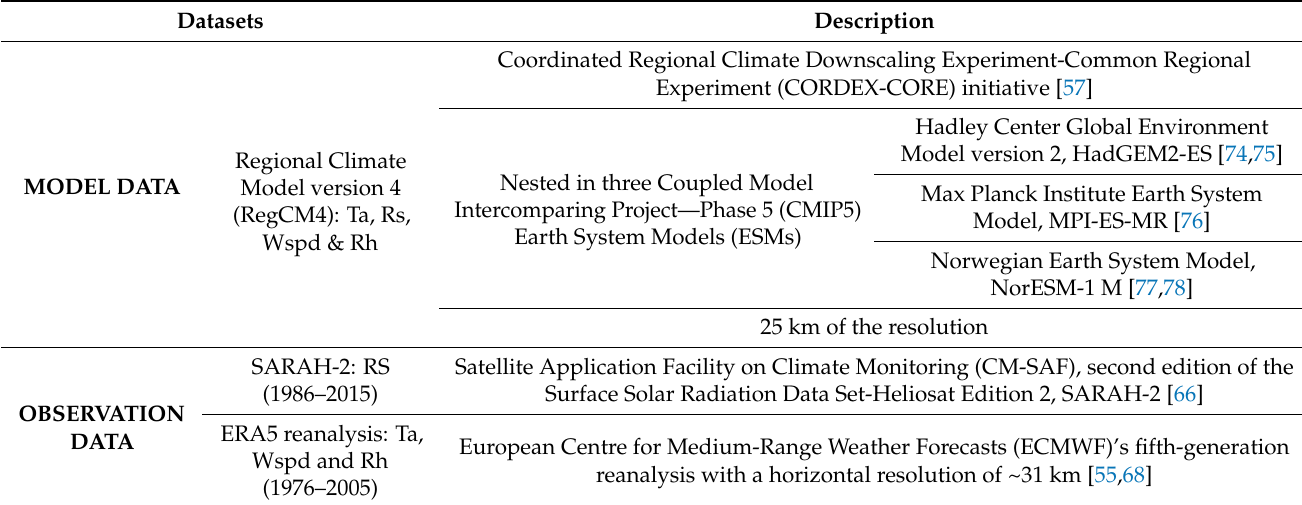
Table 2. Model and observation